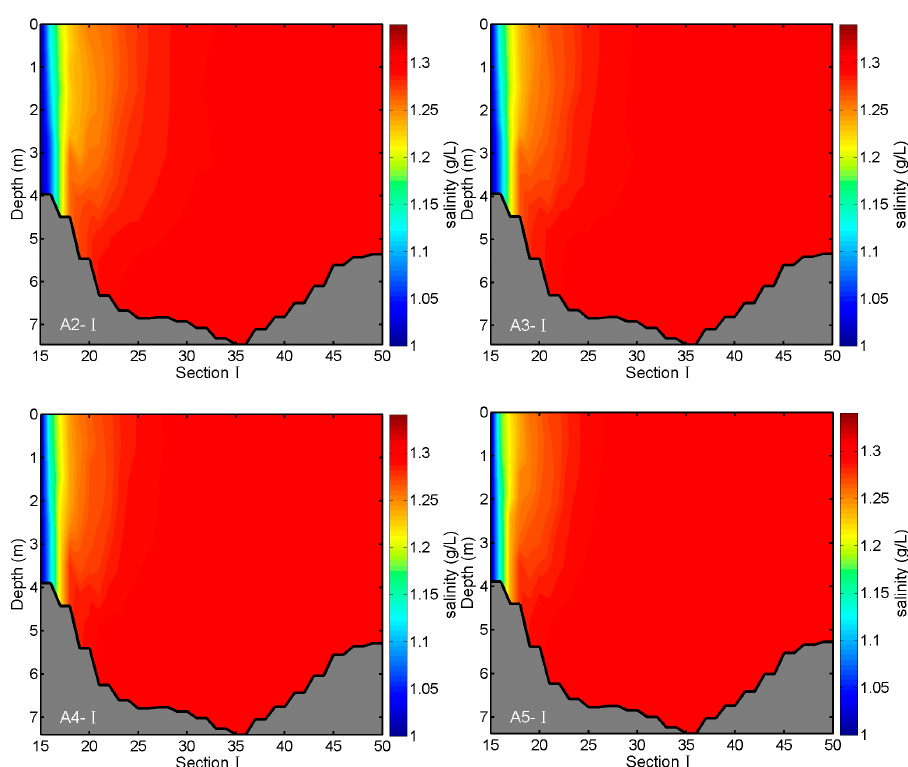
Figure 12. Distribution of modeled salinity at Section I in experiment ( A2-I ) A2, ( A3-I ) A3, ( A4-I ) A4, and ( A5-I ) A5.